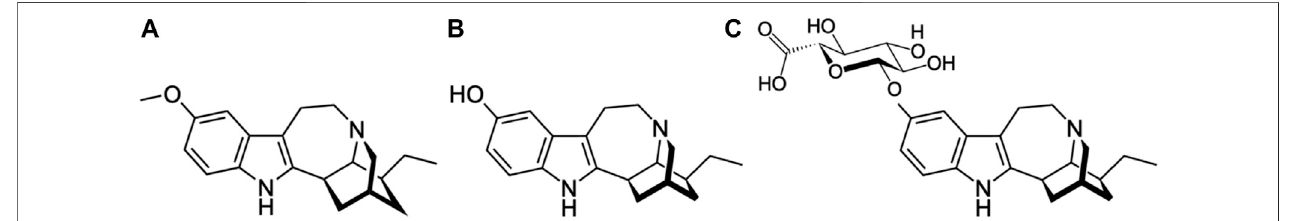
FIGURE 1 | Molecular structures of ibogaine (MW: 310.4 g/mol) (A) , noribogaine (MW: 296.4 g/mol (B) and noribogaine glucuronide (MW: 471.5) (C) .